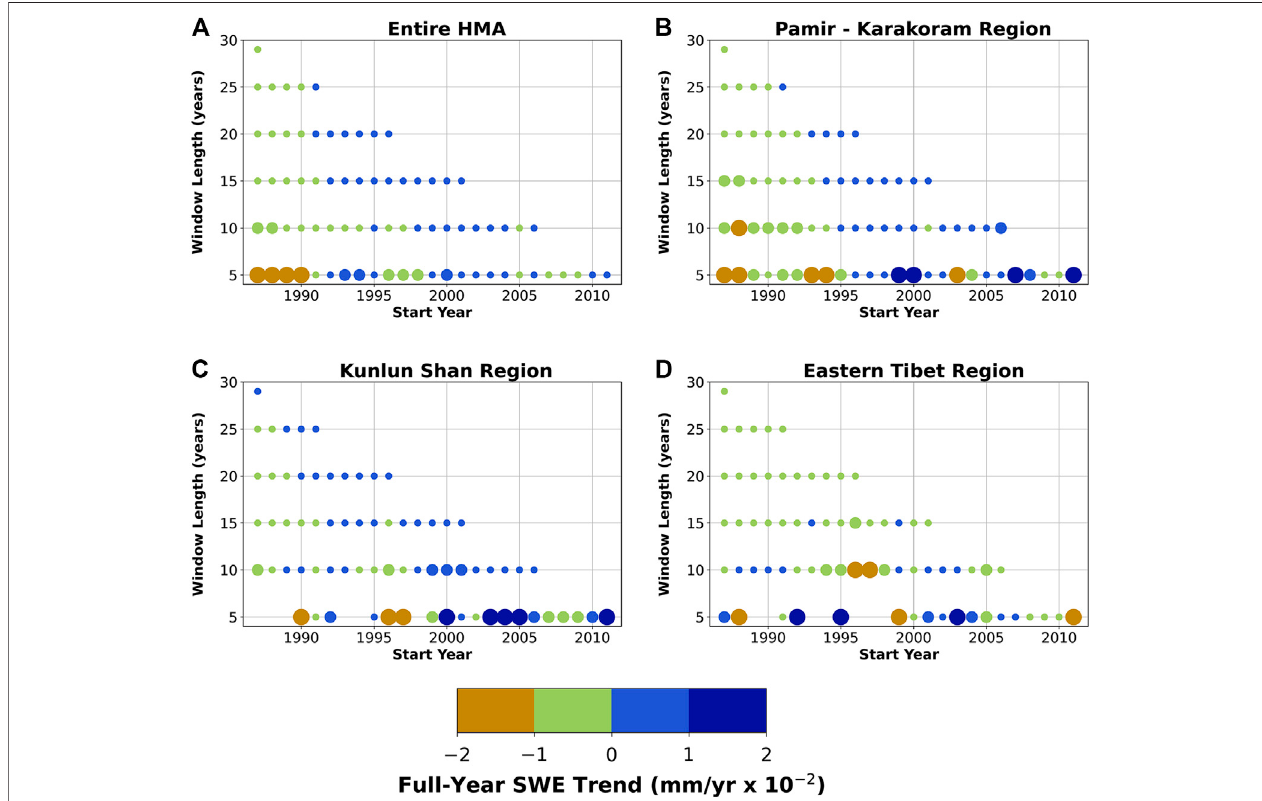
FIGURE 8 | Impact of window length on measured annual snow-water equivalent (SWE) trends. Trends calculated over (A) the entire study area, (B) the Pamir- Karakoram, (C) KunlunShan,and (D) EasternTibetanregions(see Figures1 and 4 ).Eachdotrepresentsaveragedtrendsoverasinglewindowsize(5 – 29 years)andstartyear (1987 – 2011)combination.Onlystatisticallysigni fi canttrends( p < 0.05)areincludedinthisanalysis.Largerdotsindicatepositiveornegativetrendslargerthan 1 × 10 − 2 mm/yr, verysmalldotsindicatetrendsbelow 0 . 5 × 10 − 2 mm/yr.SWEtrenddirectionishighlyvariableovershort(e.g.,5 years)timespans,butgrowsmorestableoverlongertime frames. Trends starting in the 1980s are generally more negative; there is a distinct change in the early 1990s where SWE trends become generally positive.